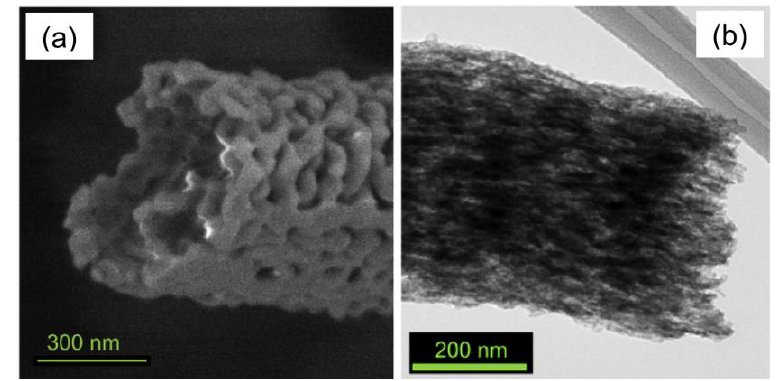
Figure 12. TEM images of ( a ) undoped α -Fe 2 O 3 and ( b ) Si-doped γ -Fe 2 O 3 fibers (reproduced from reference [140] with permission. Copyright 2018, Elsevier).